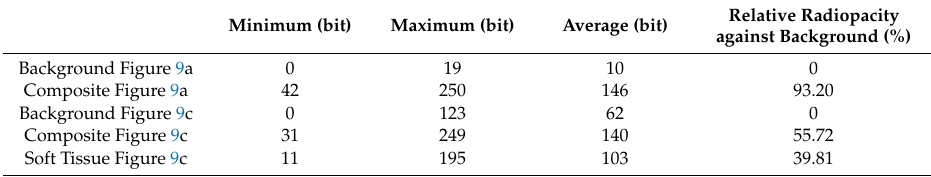
Figure 10. Images of radiopaque validation of PU–INU50. ( a ) X-Ray imaging and ( b ) grayscale histogram of the prototype marker, ( c ) X-Ray imaging, and ( d ) histogram of the prototype marker inside model tissue. Table 6. Grayscale data from radiopaque analysis done to the composite X-Ray images.